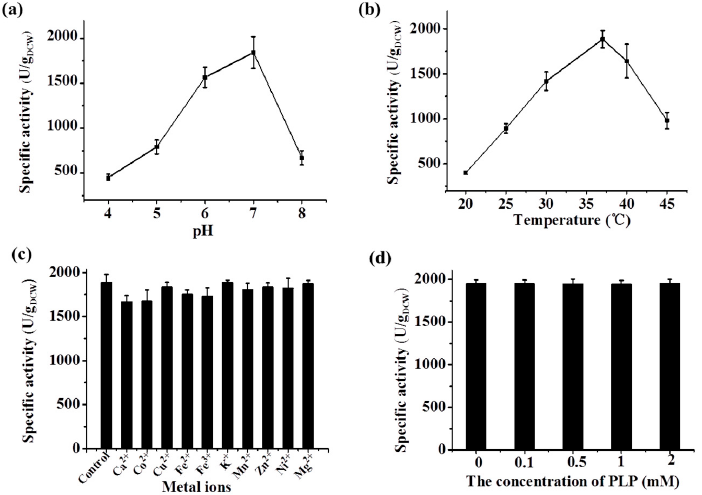
Figure 4. Characterization of the recombinant whole ‐ cell BL21 ‐ LYR. ( a ) Optimal pH of the recombinant BL21 ‐ LYR; ( b ) optimal temperature of the recombinant BL21 ‐ LYR; ( c ) metal ion preference of the recombinant BL21 ‐ LYR; ( d ) the effect of PLP on the activity of the whole ‐ cell BL21 ‐ LYR. Data are mean ± SD for three replicates.